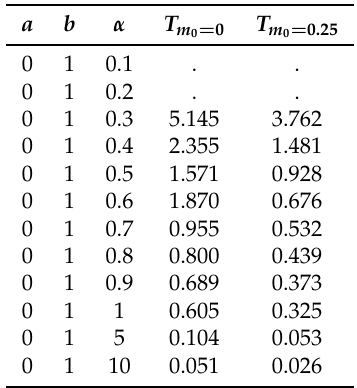
Table 1. Solvability of the ODE (52) with the states a = 0 and b = 1.